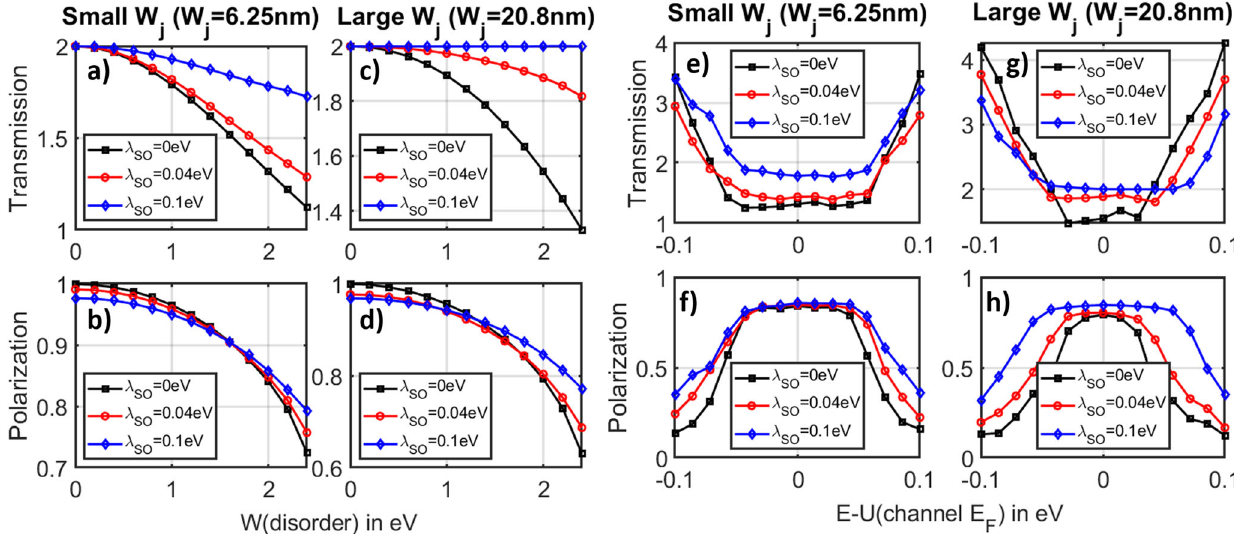
Fig. 5 Numerical results for different combinations of W j = 6.25, 20.8 nm and λ SO = 0, 0.04, 0.1 eV. a – d Results for T and Pv plotted against varying disorder strength W for channel electrochemical potential, E − U = 0. e – h Results plotted against varying E − U over the band gap for W = 2 eV. The case having W j = 20.8 nm and λ SO = 0.1 eV clearly outperforms the rest.